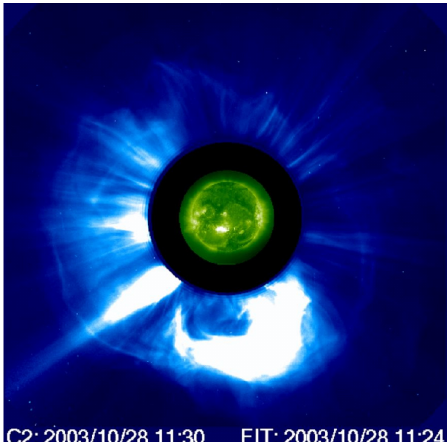
Fig. 2. Image of the X17.2 flare on 28 October 2003 recorded with SOHO/EIT (Extreme ultraviolet Imaging Telescope) and the asso- ciated halo CME recorded with SOHO/LASCO (Large Angle and Spectrometric Coronagraph). Pictures: